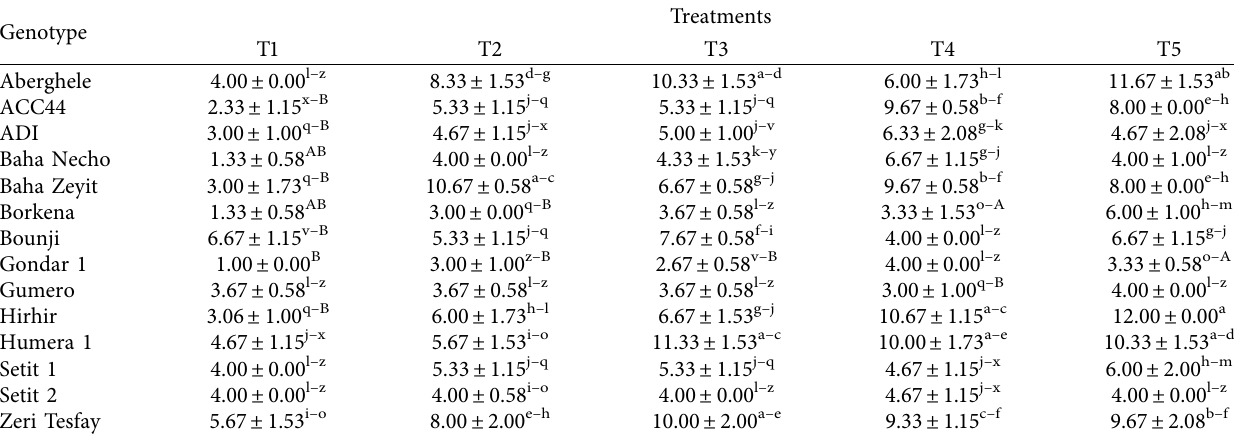
Table 2: Interaction effects of PGRs supplements and genotypes on the mean shoot number.